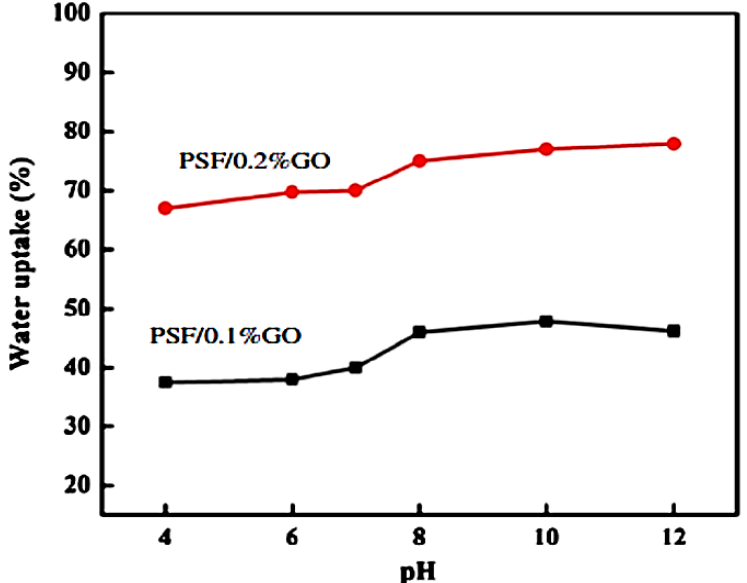
Figure 13. The effect of pH on water uptake for PSF/GO membranes [143]. PSF/GO — polysulfone/graphene oxide. Reproduced with permission from reference [143]. Copyright 2013 Elsevier.